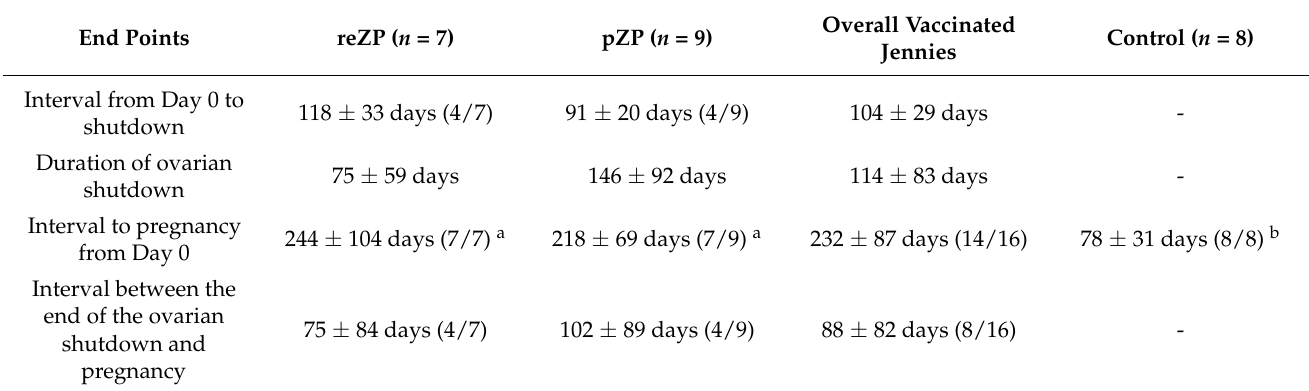
Table 1. Intervals for ovarian shutdown and pregnancy in jennies vaccinated with recombinant zona pellucida (reZP), porcine native zona pellucida (pZP) vaccines, or placebo